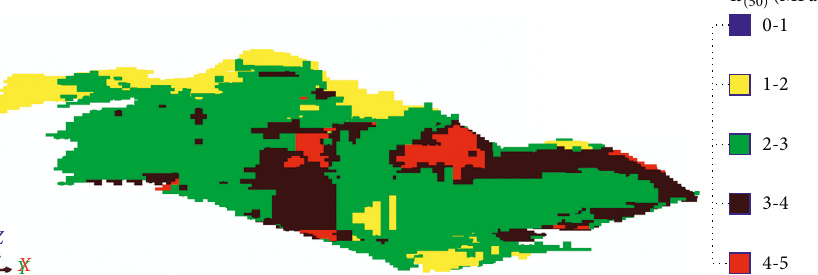
Figure 16: The spatial distribution map of Is